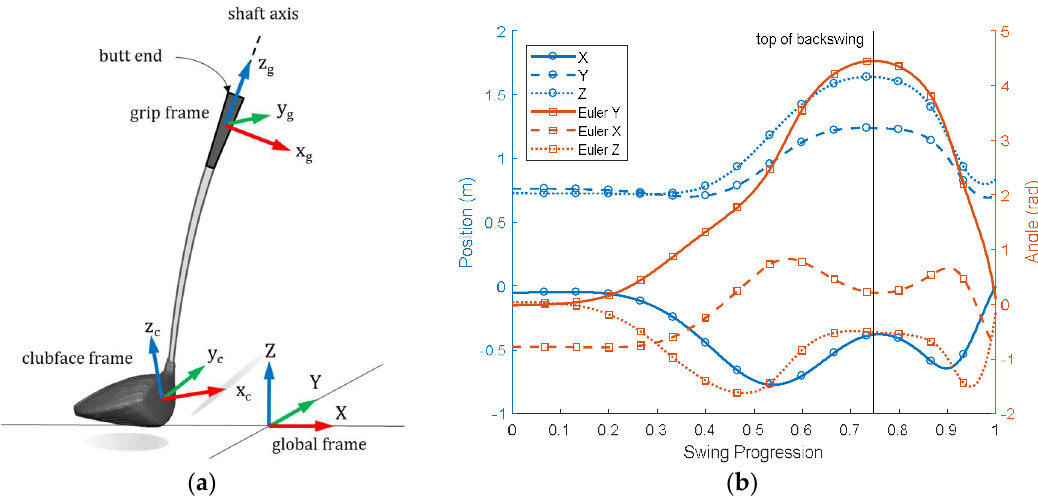
Figure 1. ( a ) Motion capture frames of reference; ( b ) 6-DOF grip motion for representative